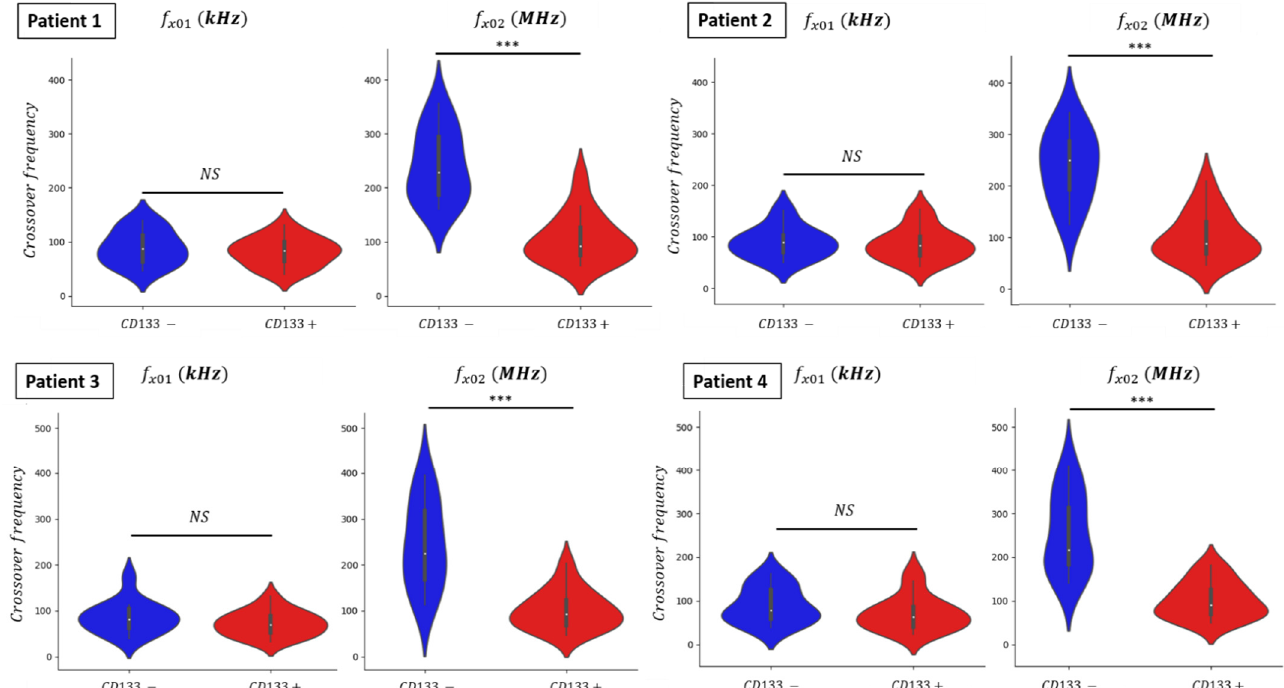
Figure 11. Graphic violin plot representation of crossover frequencies f x01 and f x02 of GBM primary cells collected from four different patients. *** represents p -value < 0.001.